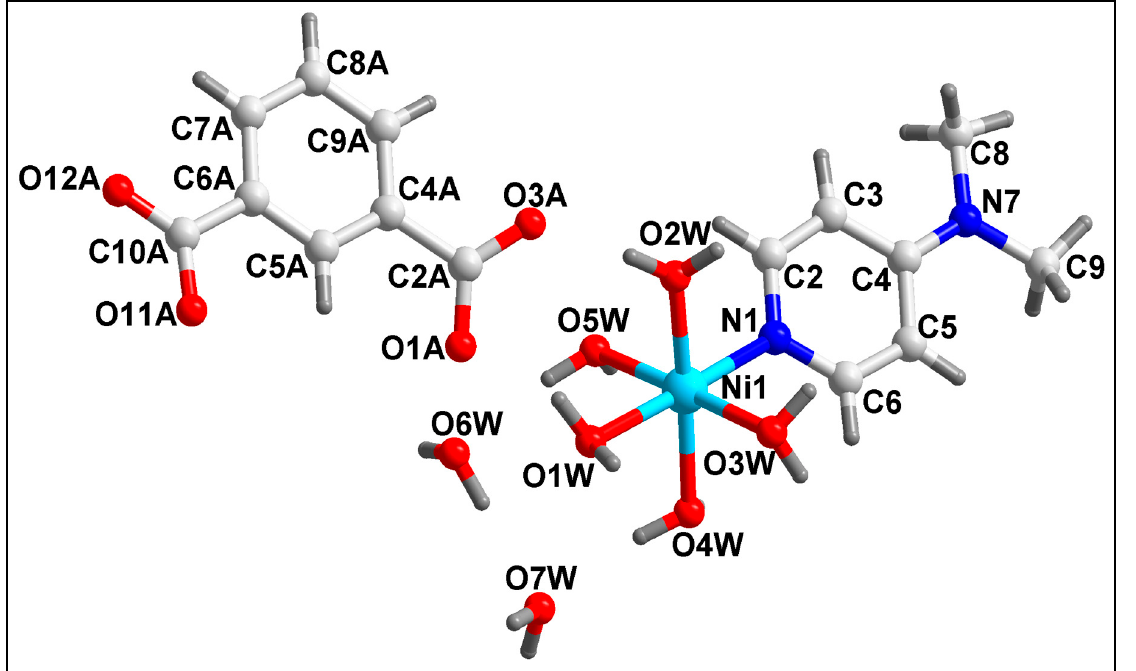
Figure 1. Molecular structure of [Ni(H 2 O) 5 (DMAP)](IPhth)·2H 2 O ( 1 ). Aromatic hydrogen atoms are omitted for clarity. Table 2. Selected bond lengths (Å) and bond angles (°) of Ni(II) and Co(II) centers in 1 and 2 ,respectively.